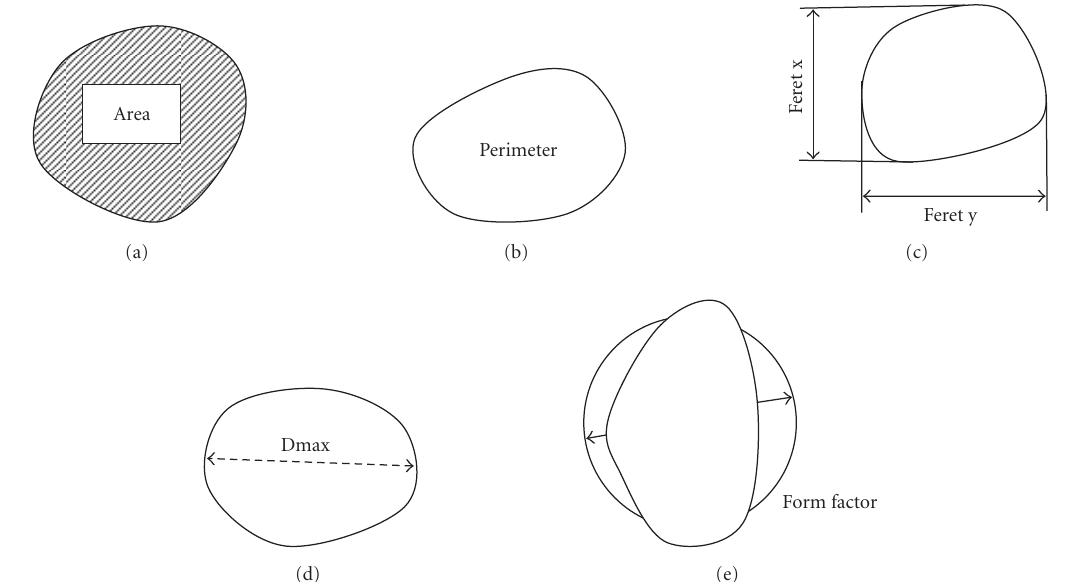
Figure 2: Shematics of the stereological parameters: (a) area (Aa); (b) perimeter (Lp); (c) feret x and feret y (d) maximal particle diameter (Dmax); (e) form factor (fL).